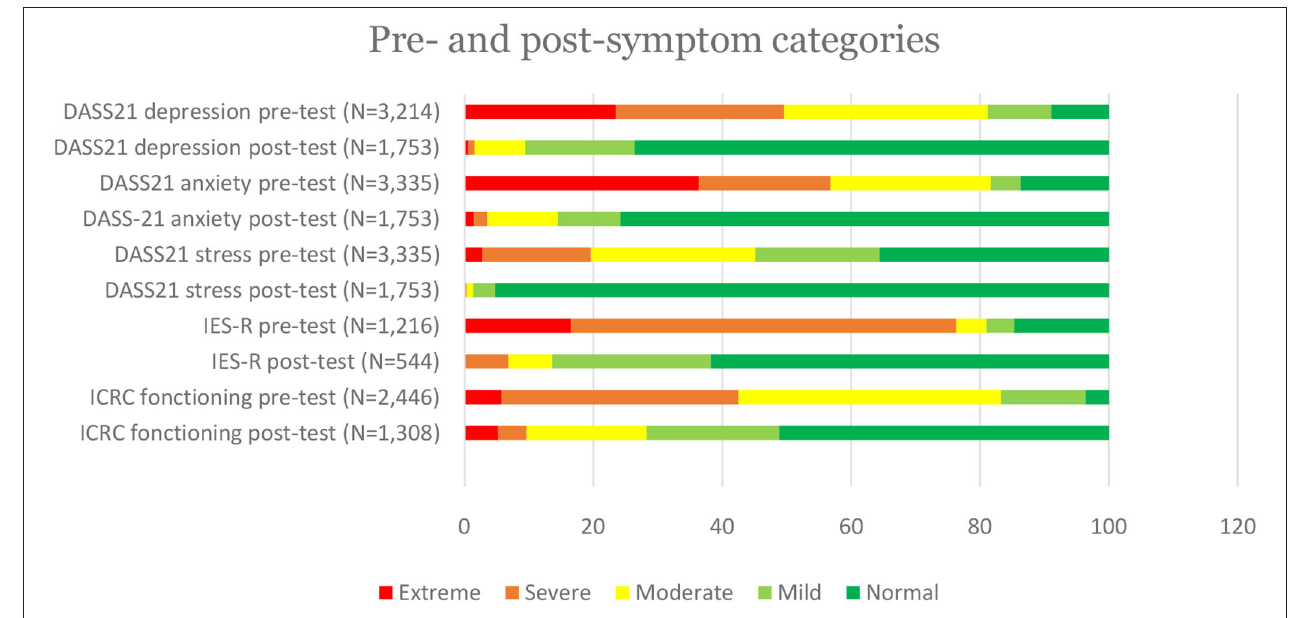
FIGURE 3 | Pre- and post-symptom